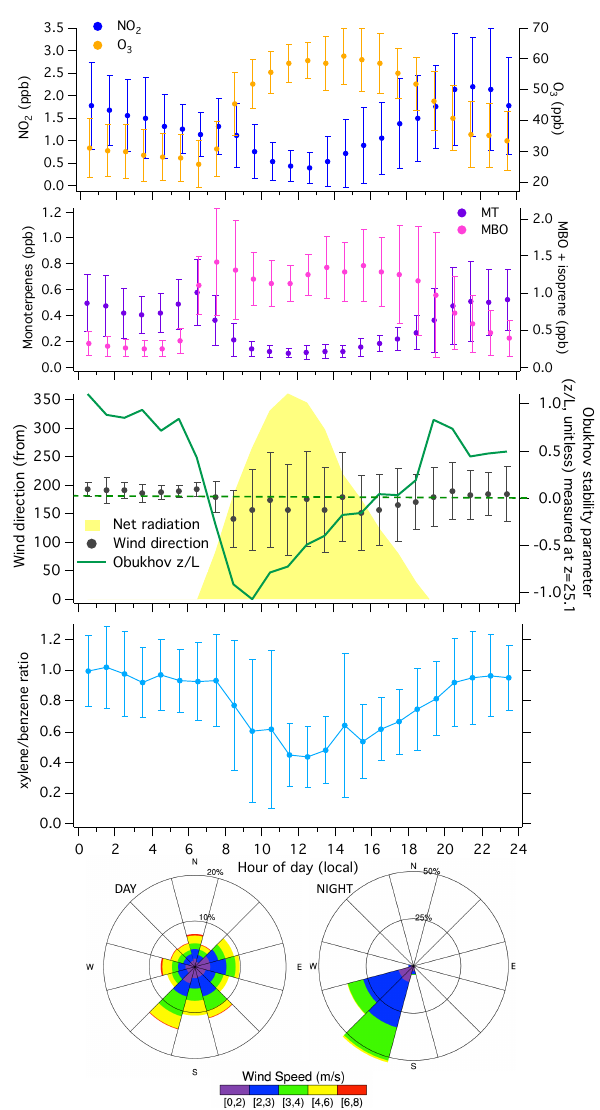
Fig. 3. Hourly binned average diurnal trends in NO 2 (blue), O 3 (or- ange), monoterpenes (purple), methyl butenol and isoprene (pink), wind direction (grey), radiation (yellow, arbitrary units), Obukhov length (green), xylene-to-benzene ratio (aqua), and average day and night windroses at MFO, 21 July–24 August 2011. Error bars are 1 σ based on data averaged to a one-hour timebase; all points are averaged for the same hour intervals but offset slightly on some plots to make error bars easier to read. Concentrations of NO 2 and monoterpenes peak at night when they are concentrated in a shallow boundary layer, while O 3 and MBO peak during the day. Winds are dominantly from the south, with more variability during the day; ev- ery morning at sunrise the Obukhov length shows a transition from a stable nighttime inversion to a convectively mixed boundary layer, and decreasing xylene:benzene ratio shows